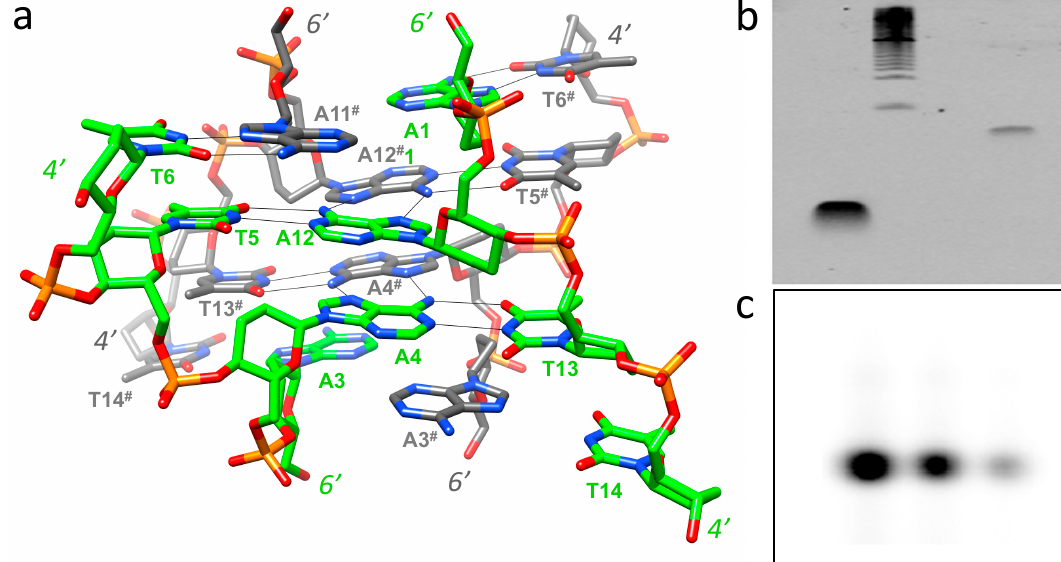
Figure 3. Probing the potential formation of the homo-DNA tetraplex outside the crystal. ( a ) Inter-duplex hydrogen bonding interactions that stabilize the homo-DNA dimer of dimers in the crystal structure of the octamer dd(CGAATTCG). Carbon atoms of one duplex are colored in green, those in the other are colored in gray, and hydrogen bonds are thin solid lines. ( b ) Native PAGE for d(CGAATTCG) (left lane) and dd(CGAATTCG) (right lane) using ethidum bromide as the staining agent (the marker lane is in the middle). ( c ) Native PAGE for dd(CGAATTCG) using radioactively labeled oligonucleotide. The three lanes represent different concentrations (2, 1, and 0.5 pm; from left to right).